Question: Does the figure show an increasing or a decreasing trend?
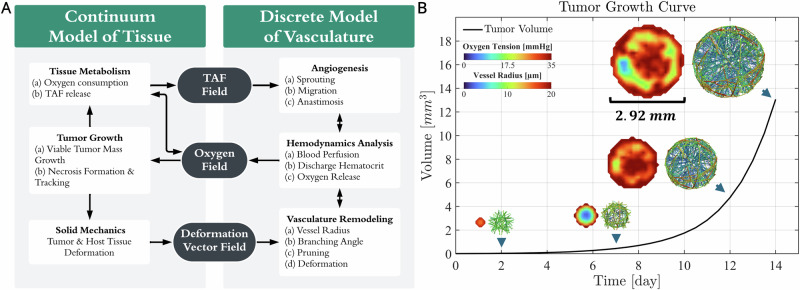
Answer: increasing